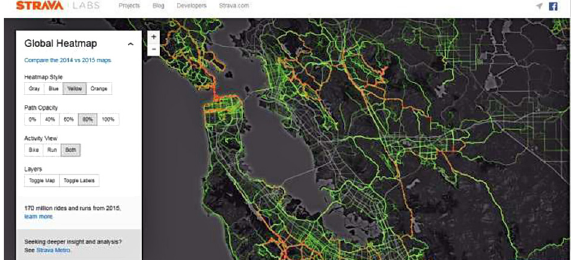
Figure 2. A fragment of a heatmap in Strava service (Strava, 2017)